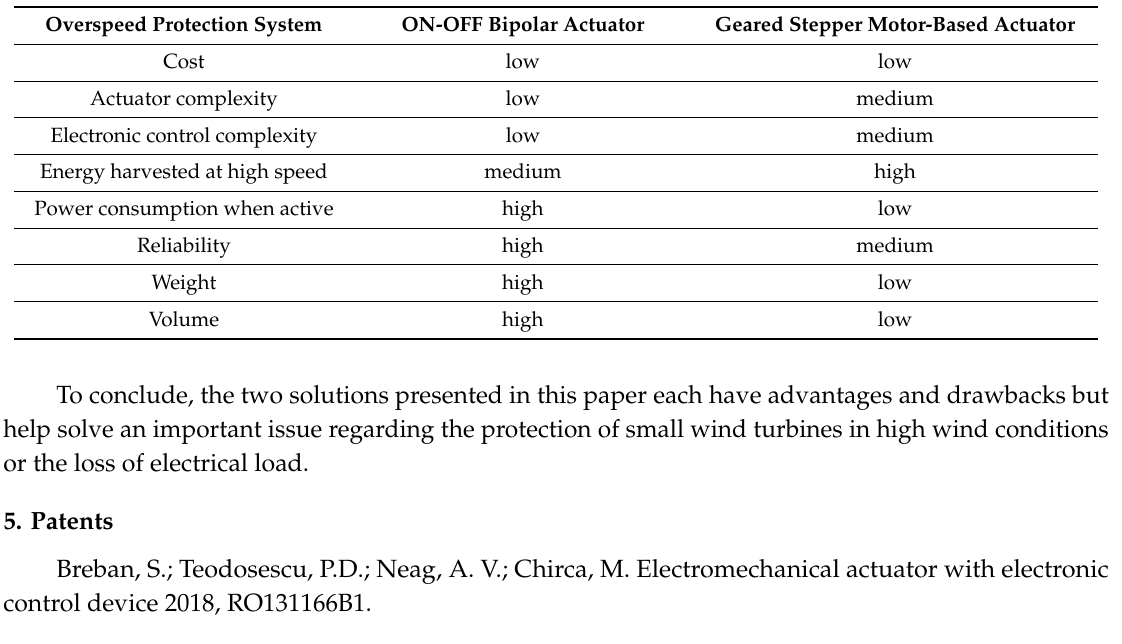
Table 2. Comparison of the proposed